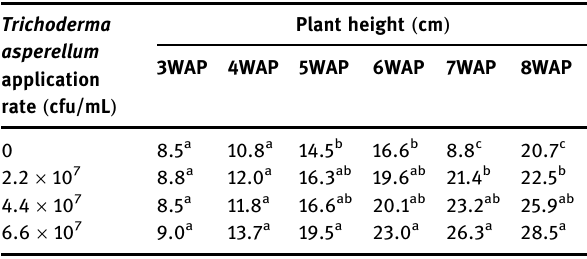
Table 2: E ff ect of Trichoderma asperellum on plant height of